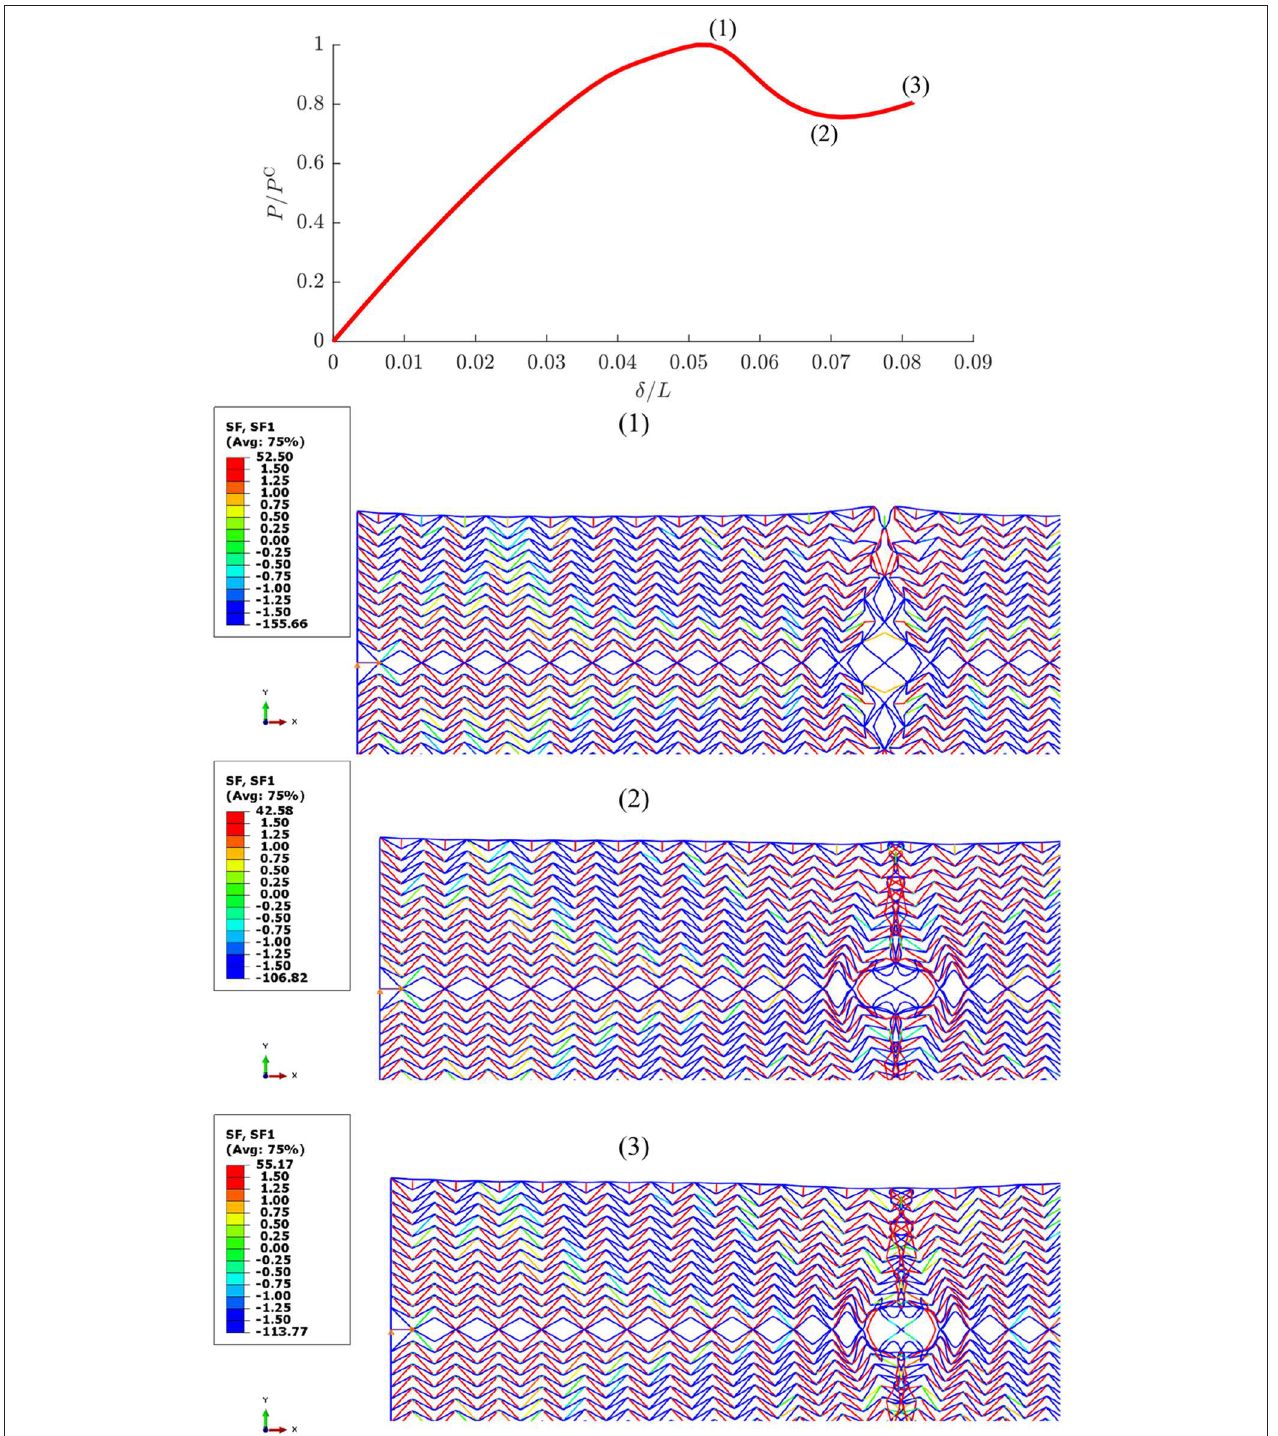
FIGURE 12 | Normalized load P / P C vs. normalized end-shortening δ/ L behavior for AVHI ′ 1 with axial force (“SF”) contour plots in Newtons (N) marking three distinct points on the corresponding equilibrium path.